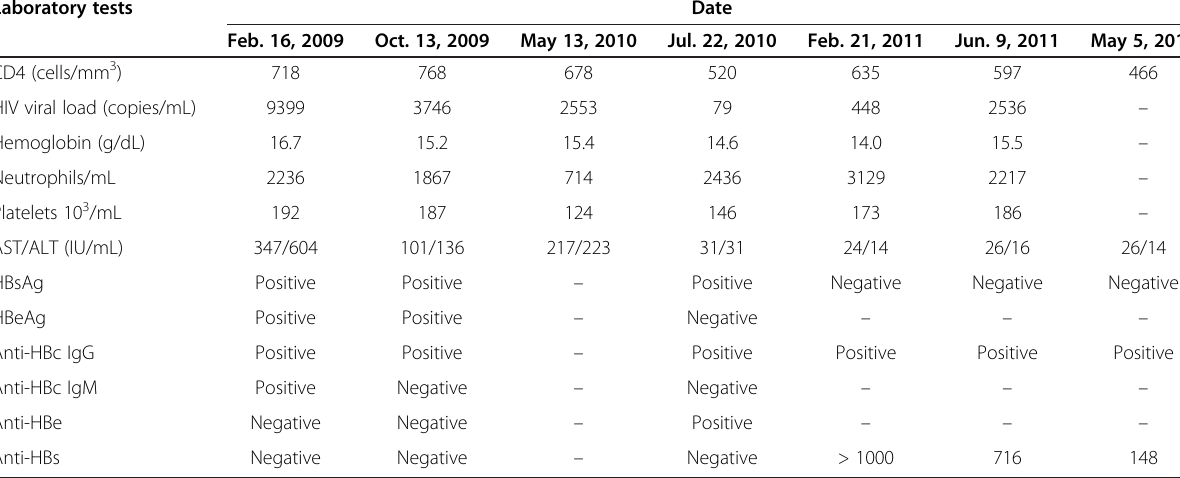
Table 1 Laboratory tests performed during follow-up Laboratory